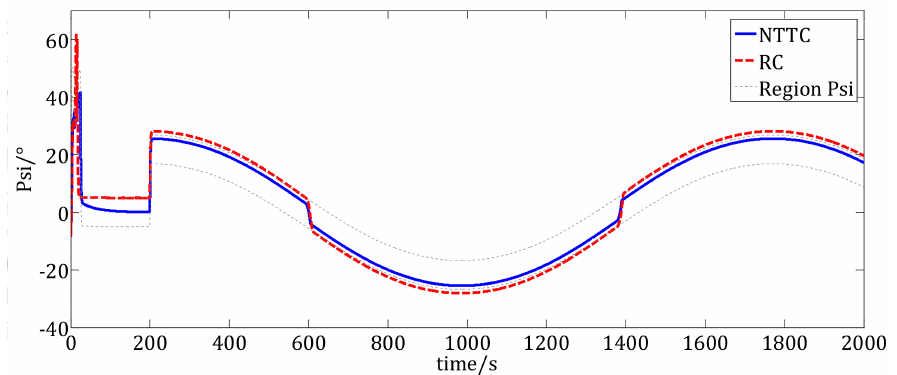
Figure 6. Yaw angles of the USV under the two control methods.